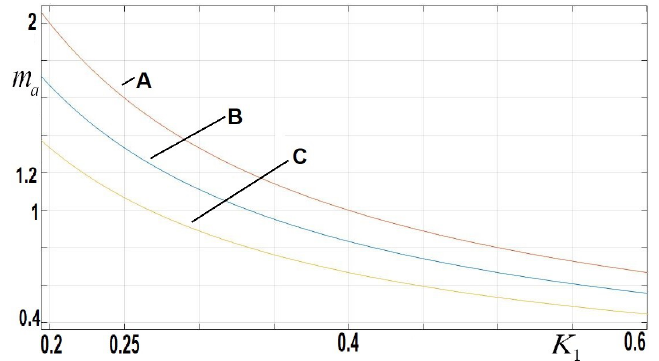
Figure 6. Hardware-OCC. ma vs. K 1 , Equation (37), The curve denoted by A: I g grows 20%, The curve denoted by B: Without correction C: I g falls